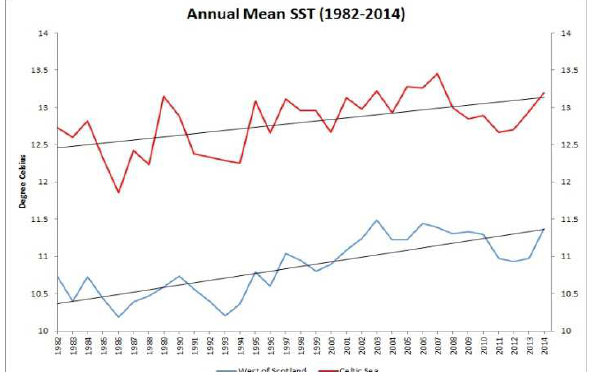
Figure 4. Annual SST for the West Scotland (Sub-area VI) and Celtic Sea (Sub-area